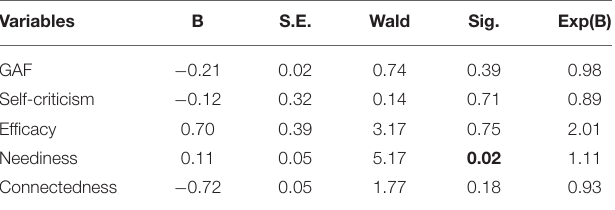
TABLE 4 | Prediction of NSSI behaviors by DEQ sub-factors in BPD adolescents.